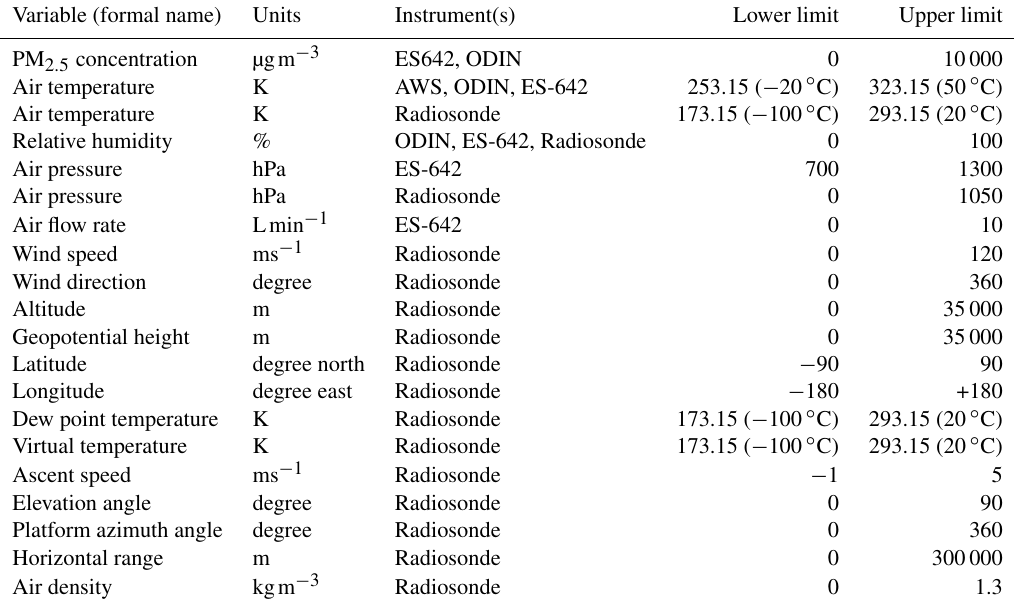
Table A1. Thresholds for pre-screening of